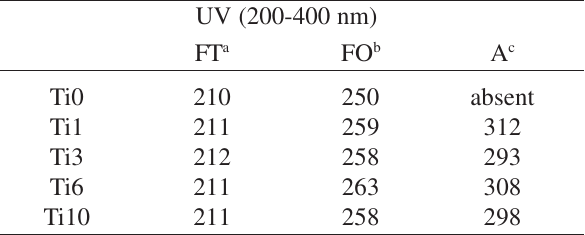
Table 2 : DRS-UV bands of